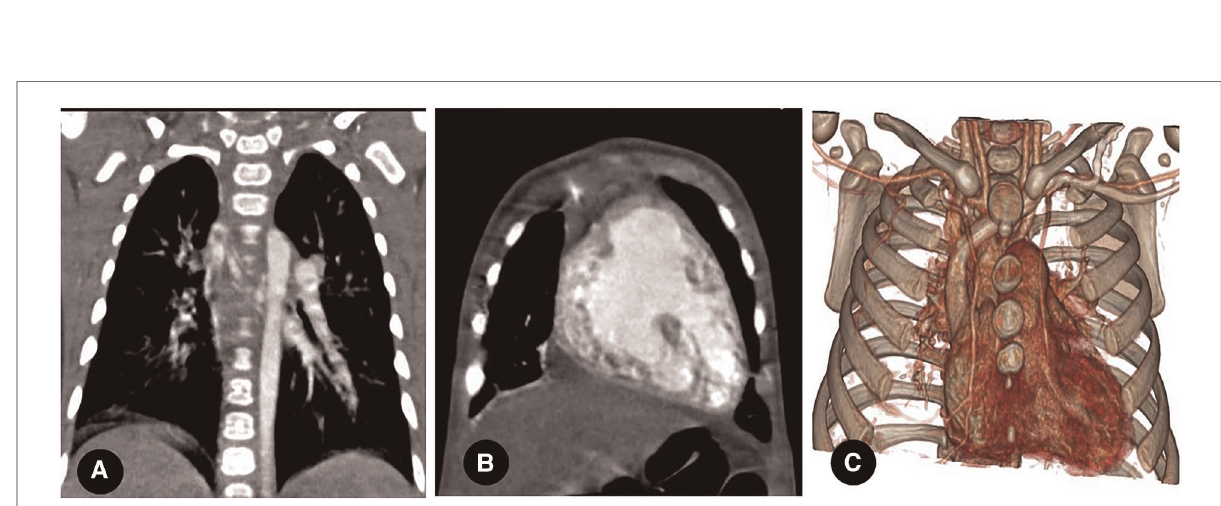
FIGURE 4 Left proximal interruption of the pulmonary artery with bilateral patent ductus arteriosus in a 4-month-old male patient. ( A ) a coronal view of the chest computed tomography angiography (CCTA) shows an open left ductus arteriosus connecting to the distal end of the left pulmonary artery. ( B ) an oblique coronal view of the CCTA shows an open right ductus arteriosus connecting the descending aorta to the proximal end of the right pulmonary artery.